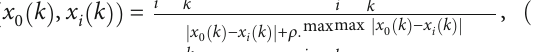
Figure 18: Surface subsidence curve of di ff erent internal friction angles in strike